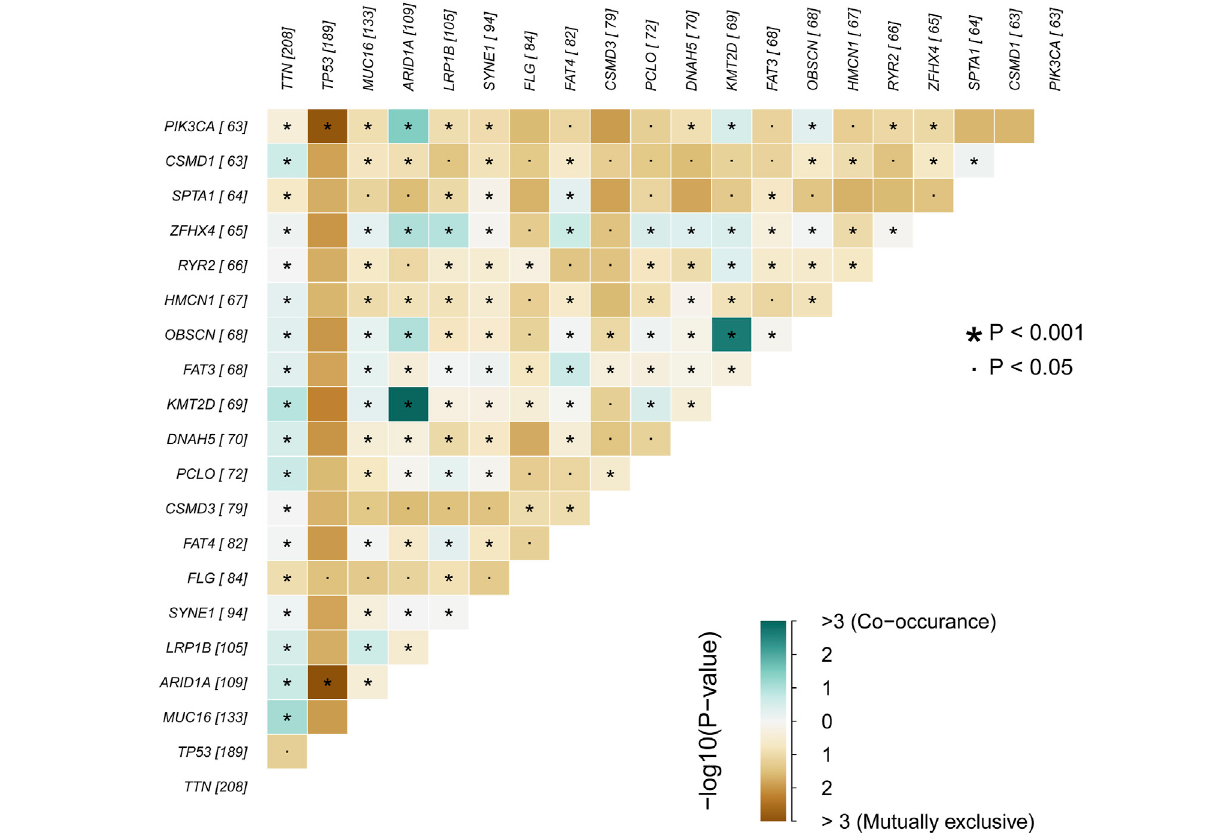
FIGURE 3 | The correlation graph of STAD samples.